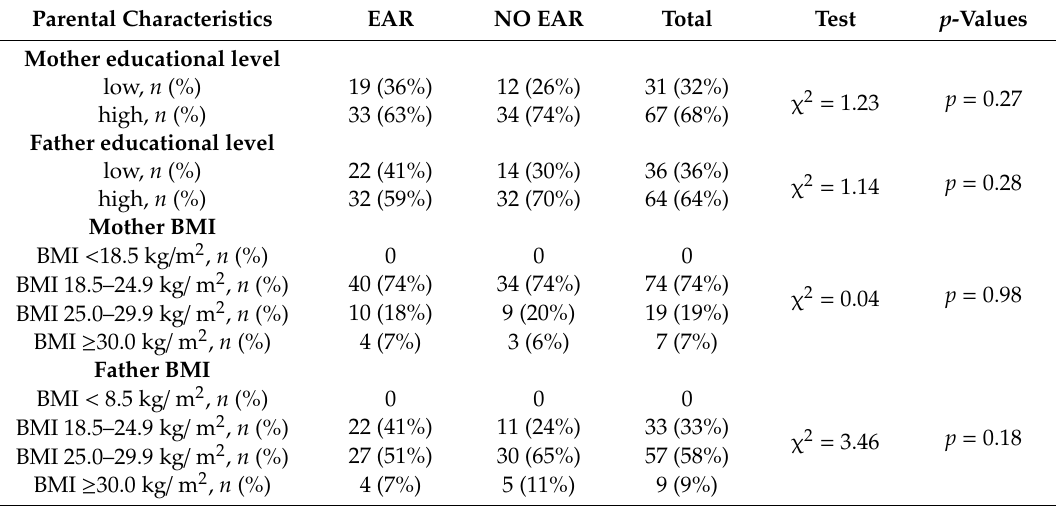
Table 3. Parental characteristics according to timing of adiposity